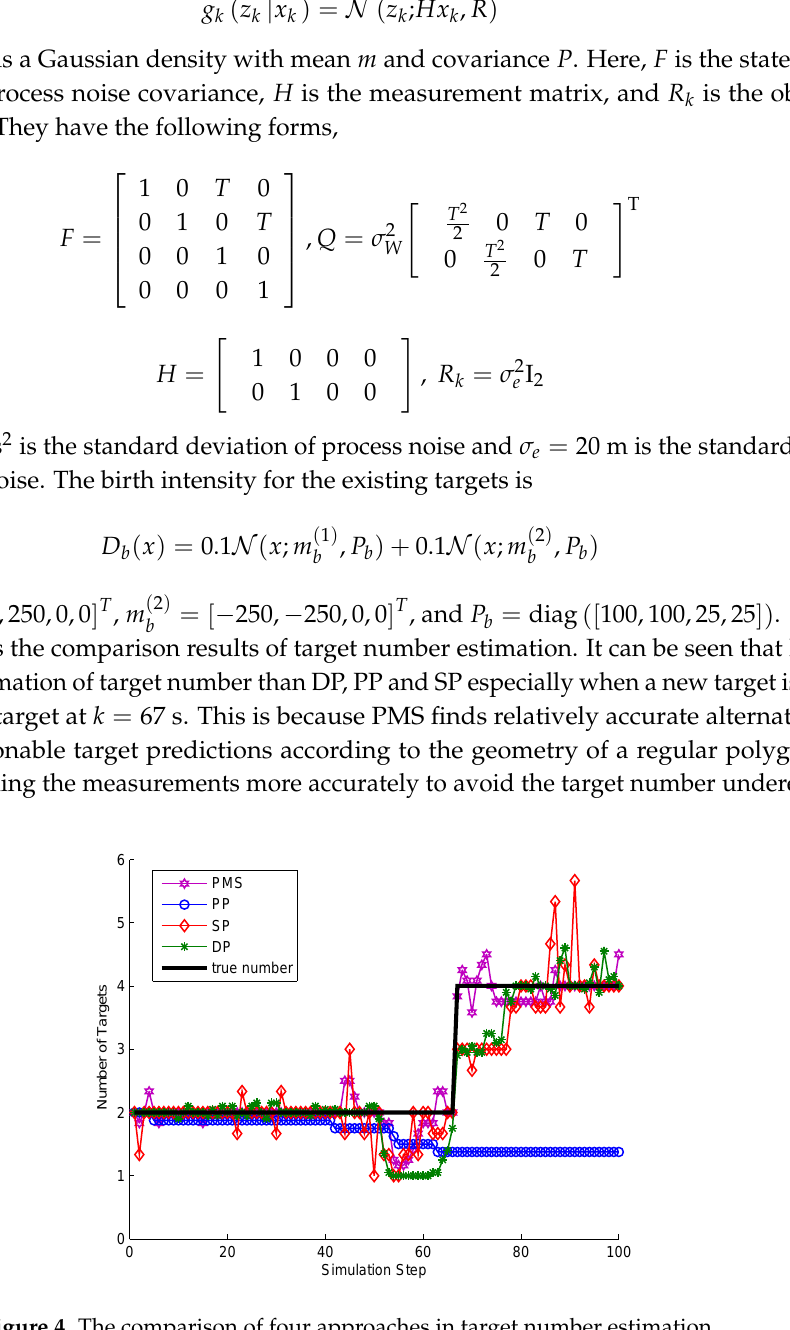
Figure 4. The comparison of four approaches in target number